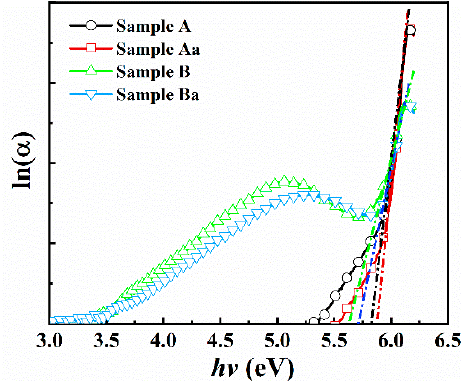
Figure 8. The relation between ln( α ) and photon energy ( h υ ) for samples.